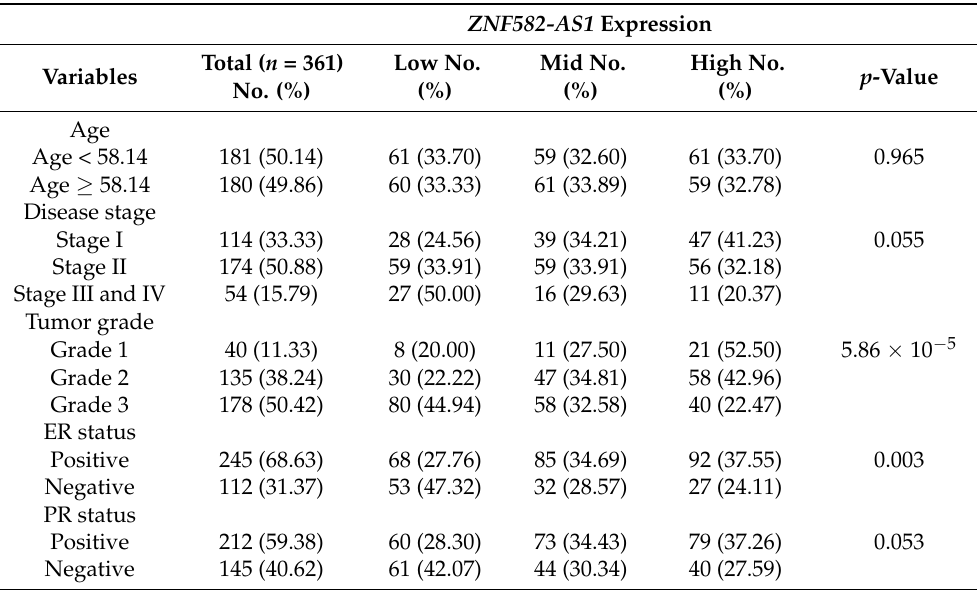
Table 1. Associations between ZNF582-AS1 expression and clinicopathological characteristics of breast cancer.